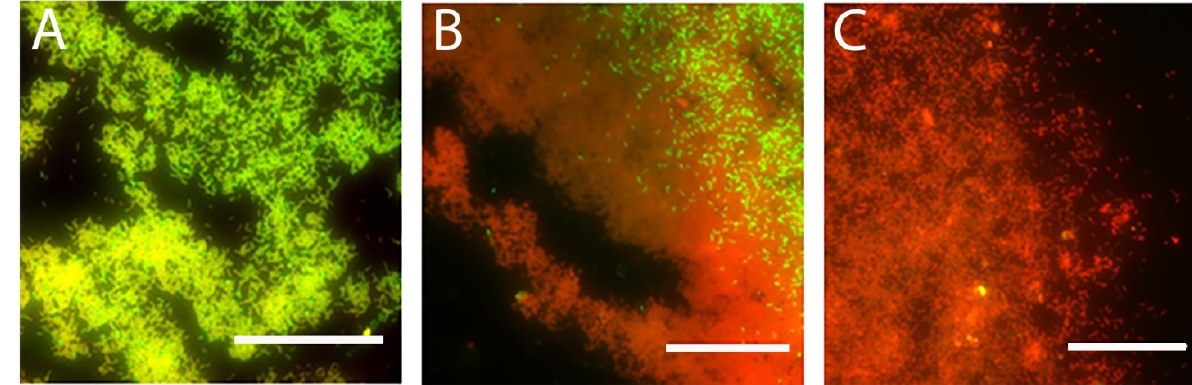
Figure 7. Representative images from live/dead staining of EPS-stripped biofilms. ( A ) Untreated EPS-stripped biofilms. ( B ) EPS-stripped biofilms treated with 16.5 µM MAG2 for 30 min. ( C ) EPS-stripped biofilms treated with 16.5 µM MAG2 for 24 h. Even with its EPS removed, the cells of the untreated stripped biofilm have mostly retained the SYTO 9 dye, while the cells in the treated biofilms have been permeabilized and taken up PI. Note the contrast between panel C and the biofilm with intact EPS in Figure 1C. The scale bar is 50 µm.